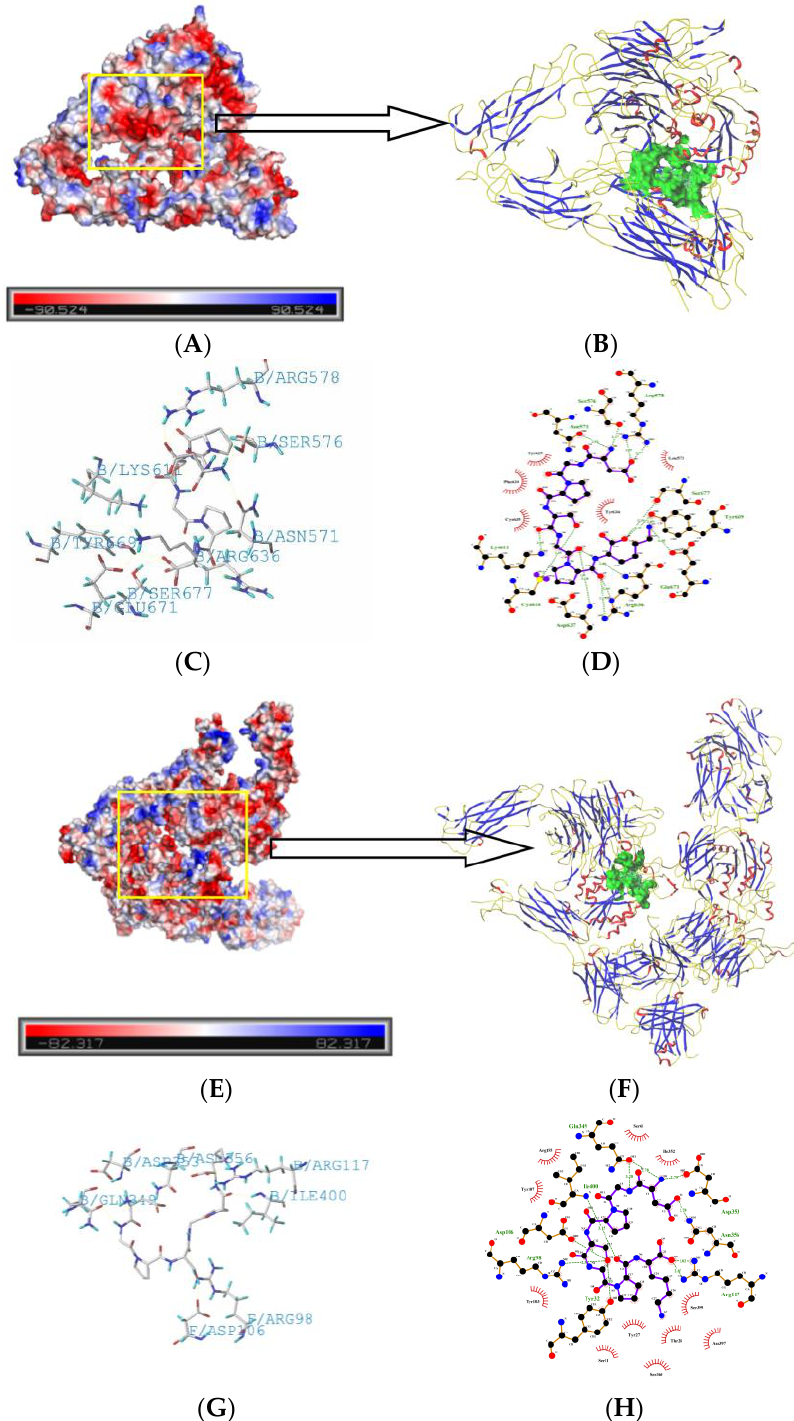
Figure 9. Docking simulation for the interaction of DGPSGPK and integrins: PDB: 1L5G ( A – D ) and PDB: 3VI4 ( E – H ). ( A ) and ( E ) surface electrostatic potential energy of the integrator, red is negative voltage, blue is positive voltage; ( B ) and ( F ) 3D structure of DGPSGPK docked with integrin; ( C ) and ( G ) interaction sites of DGPSGPK and amino acids in the integrins; ( D ) and ( H ) 2D diagram of the interaction sites of DGPSGPK and amino acids in the integrins.